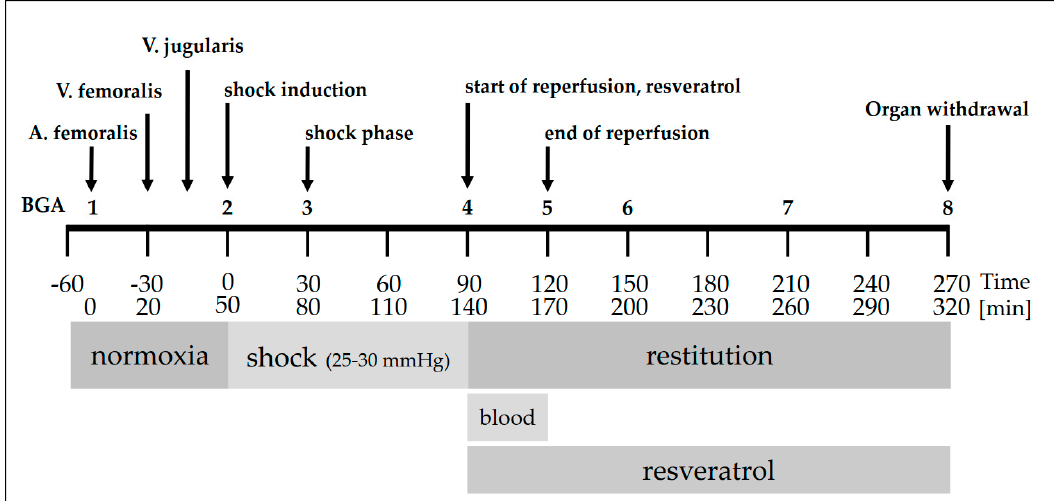
Figure 1. Timetable of the experimental procedures. Blood samples (0.7 mL) for blood gas